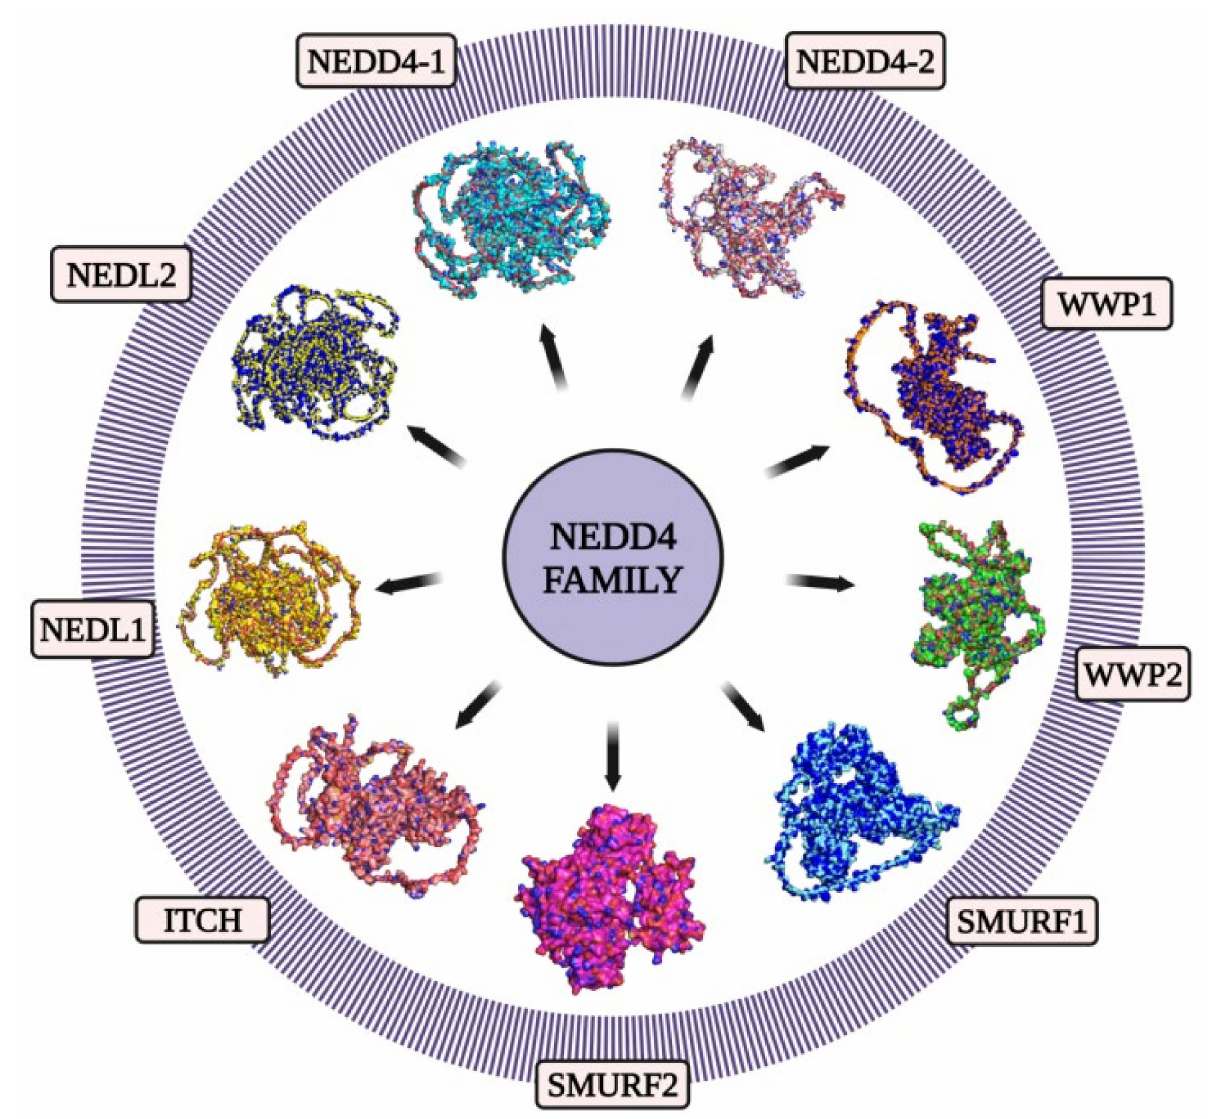
Figure 3. Structural representation of the founding members of the NEDD4 family of E3 HECT ubiquitin ligases in humans: NEDD4-1 (UniProt ID: P46934), NEDD4-2 (UniProt ID: Q96PU5), WWP1 (UniProt ID: Q9H0M0), WWP2 (UniProt ID: O00308), SMURF1 (UniProt ID: Q9HCE7), SMURF2 (UniProt ID: Q9HAU4), ITCH (UniProt ID: Q96J02), NEDL1 (UniProt ID: Q76N89), NEDL2 (UniProt ID: Q9P2P5). These proteins’ primary structures were taken from the UniProt database. Using the AlphaFold protein structure database, the structures of these proteins were predicted. The image generation and visualization of the structures of these proteins were conducted using PyMOL [88–91]. Created using